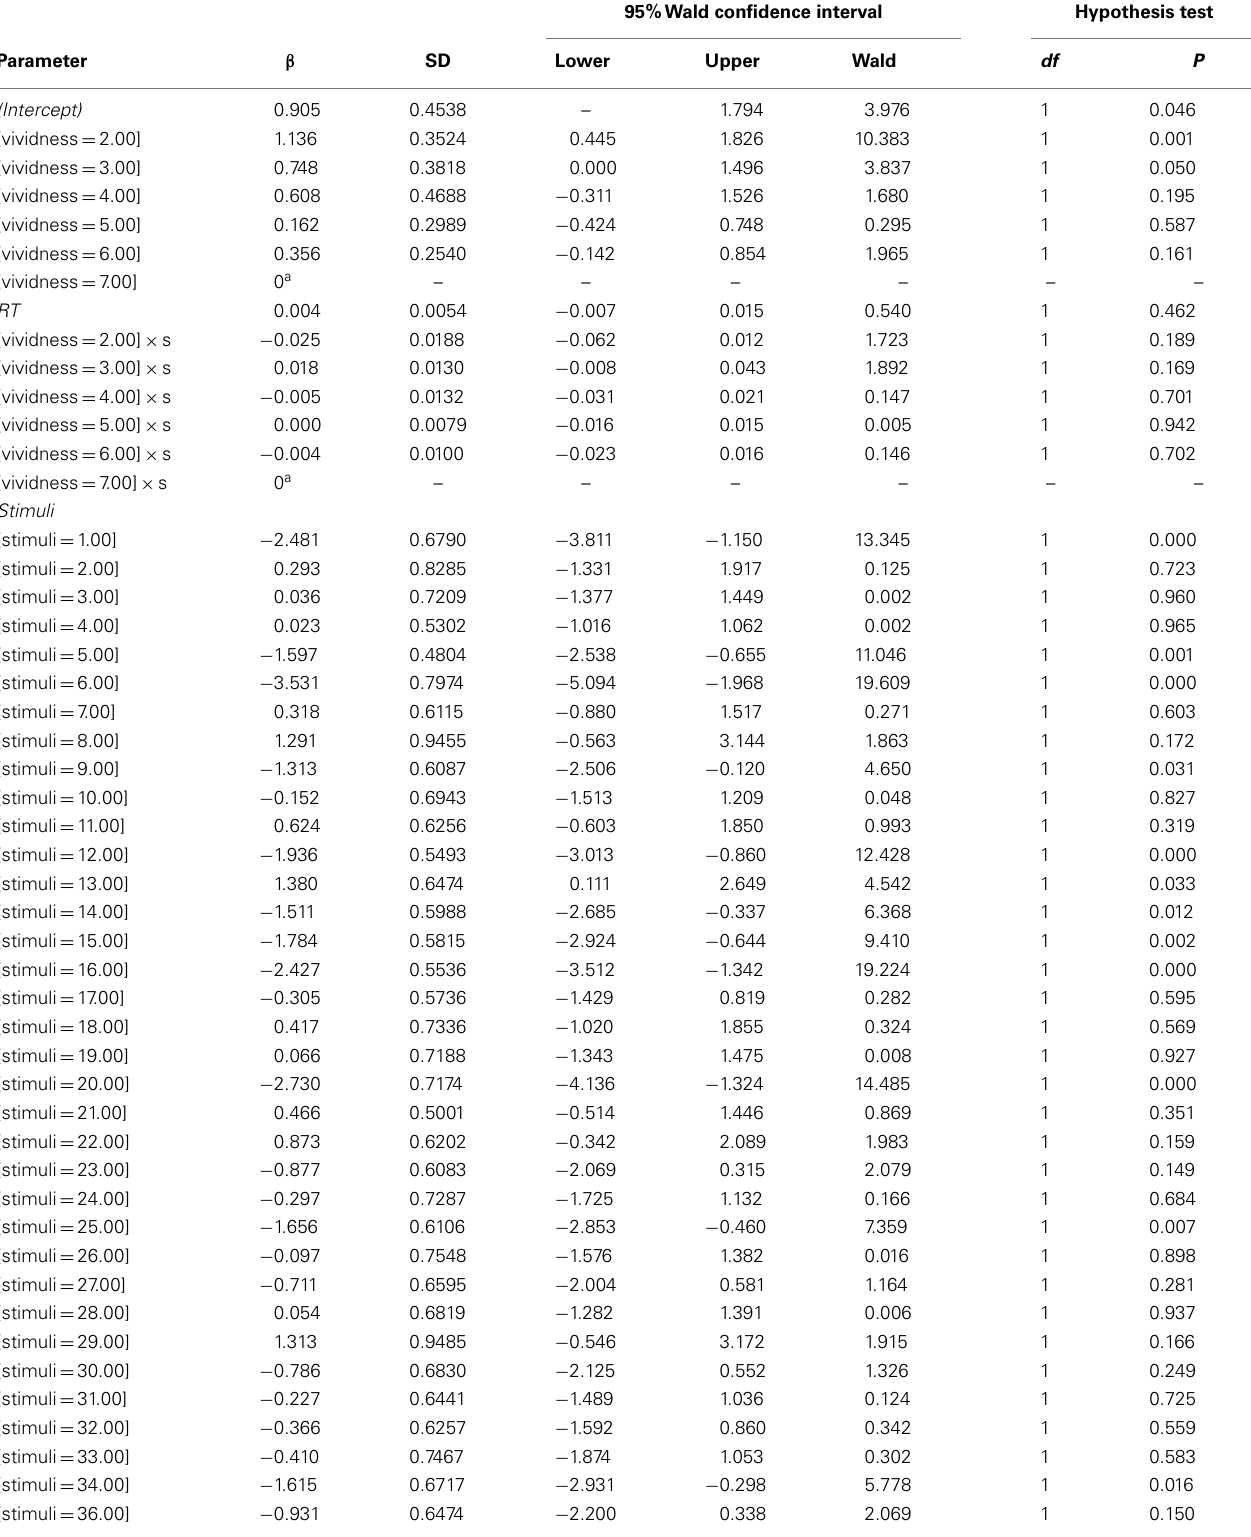
TableA6 | Parameter estimate for repeated measure logistic